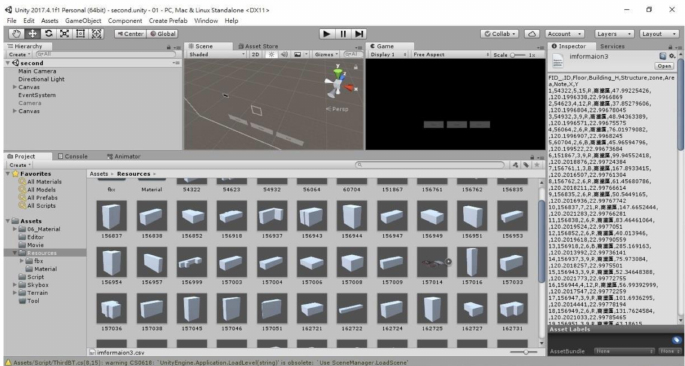
Figure 11. Unity reading database and the volume